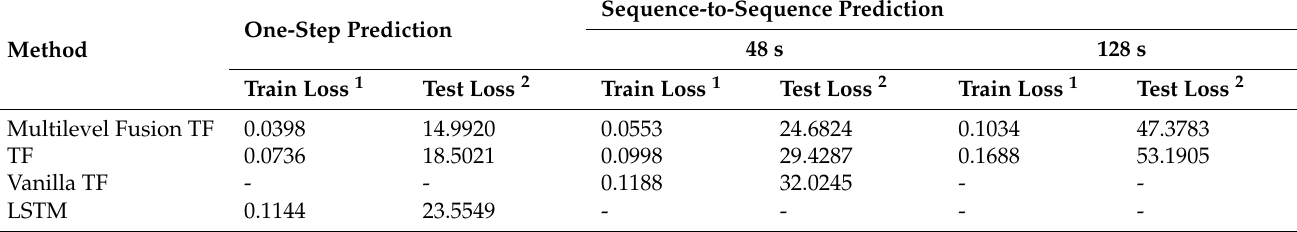
Table 4. External validation result.